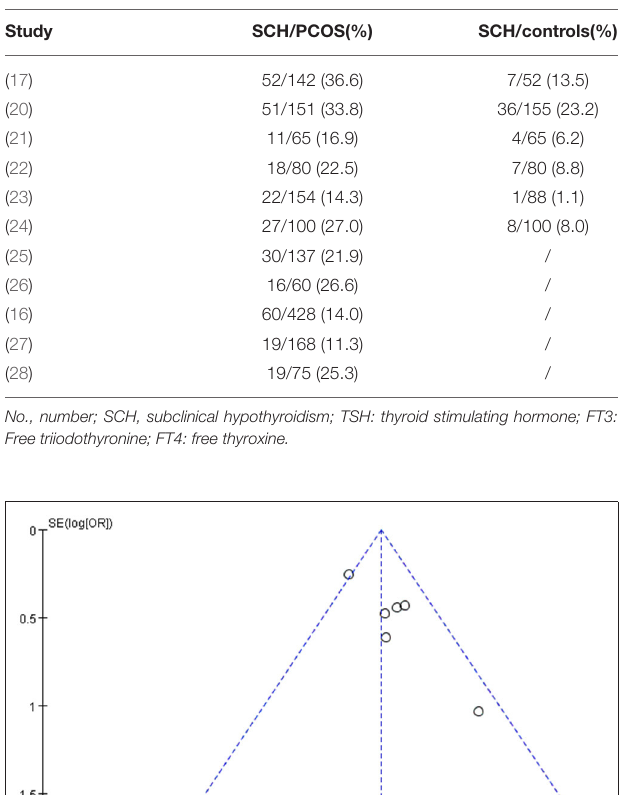
TABLE 2 | The distribution of subclinical hypothyroidism in PCOS and controls.